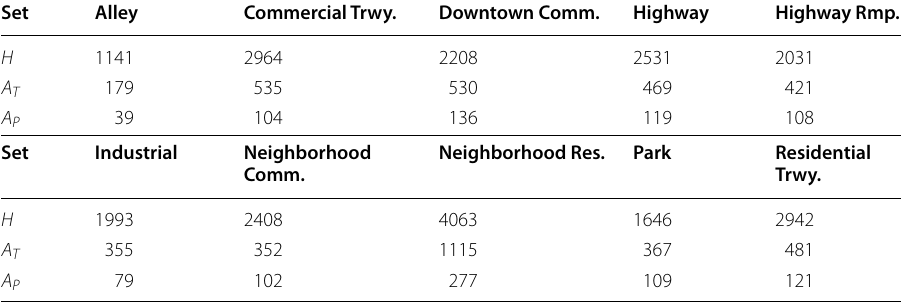
Table 1 Number of images in each street context, in the three sets: H (human-labeled), A T (human- labeled set used to train AI), and A P (AI-labeled set) Set Alley Commercial Trwy. Downtown Comm. Highway Rmp.